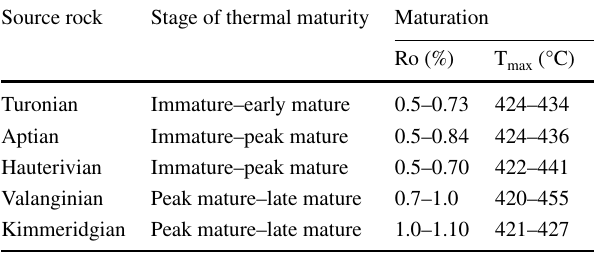
Fig. 9 T max ( a) and Ro ( b ) depth profile plots indicate two significant erosional breaks in maturity profile, possibly during the uplifts before deposition of overlying formations Table 4 Characteristic stage of thermal maturity and range values for T max and Vitrinite reflectance for the different source rock intervals adapted from Agbor